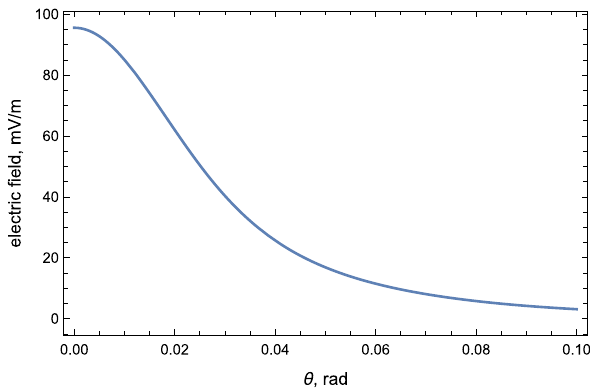
Fig. 4 Strength of electric field (33) induced by geosynchrotron radi- ation versus obervation angle θ . The parameters are chosen to be N = 10 9 , γ = 20, B = 0 . 5gauss, θ B = φ = π/